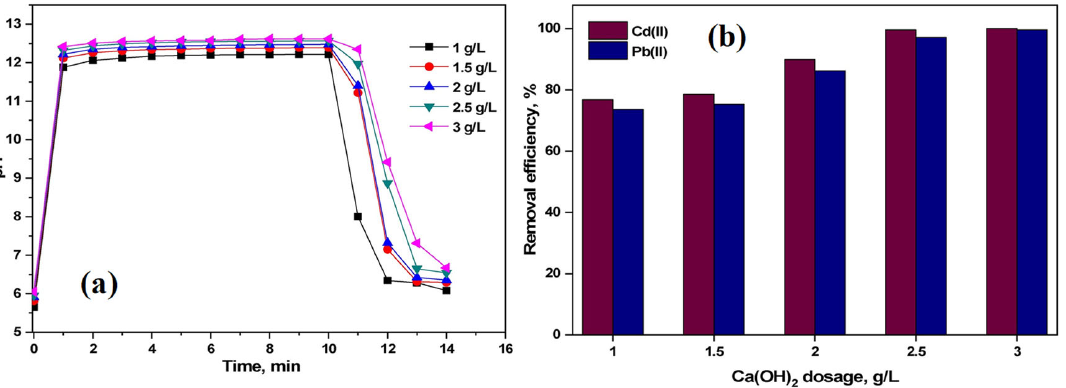
Figure 8. ( a ) Changes in pH after adding different concentrations of Ca(OH) 2 to simulated wastewater containing Cd 2+ and Pb 2+ ; ( b ) Removal rates of Cd 2+ and Pb 2+ at different Ca(OH) 2 concentrations, reproduced from [88], with permission from Elsevier, 2020.